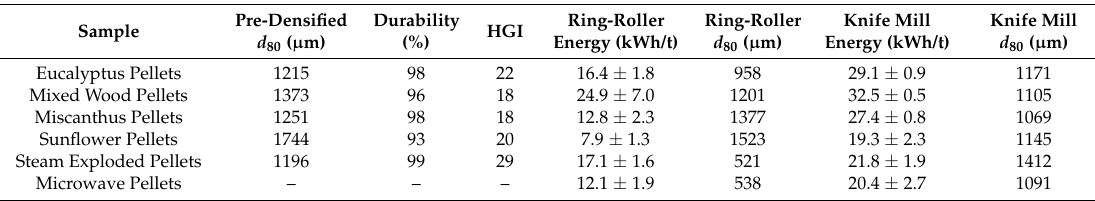
Table 1. Pre-densified 80th percentile particle size ( d 80 ), durability, and milling energy data. HGI—Hardgrove Grindability Index.